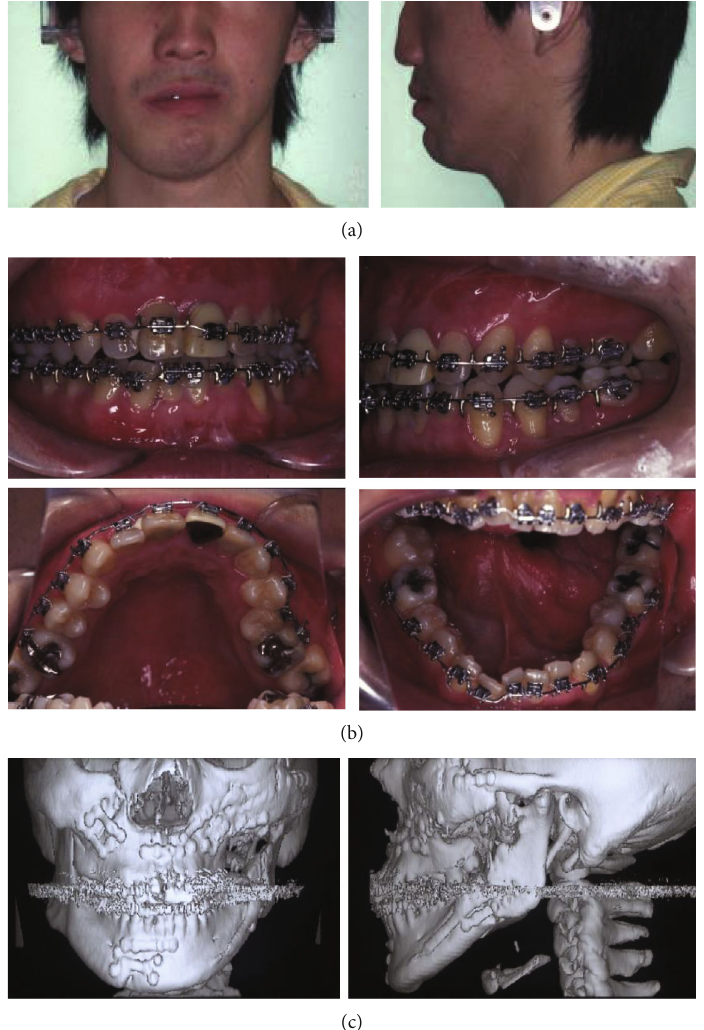
Figure 2: Facial (a) and intraoral photographs after 9 months (b) and cephalic CT images after open reduction